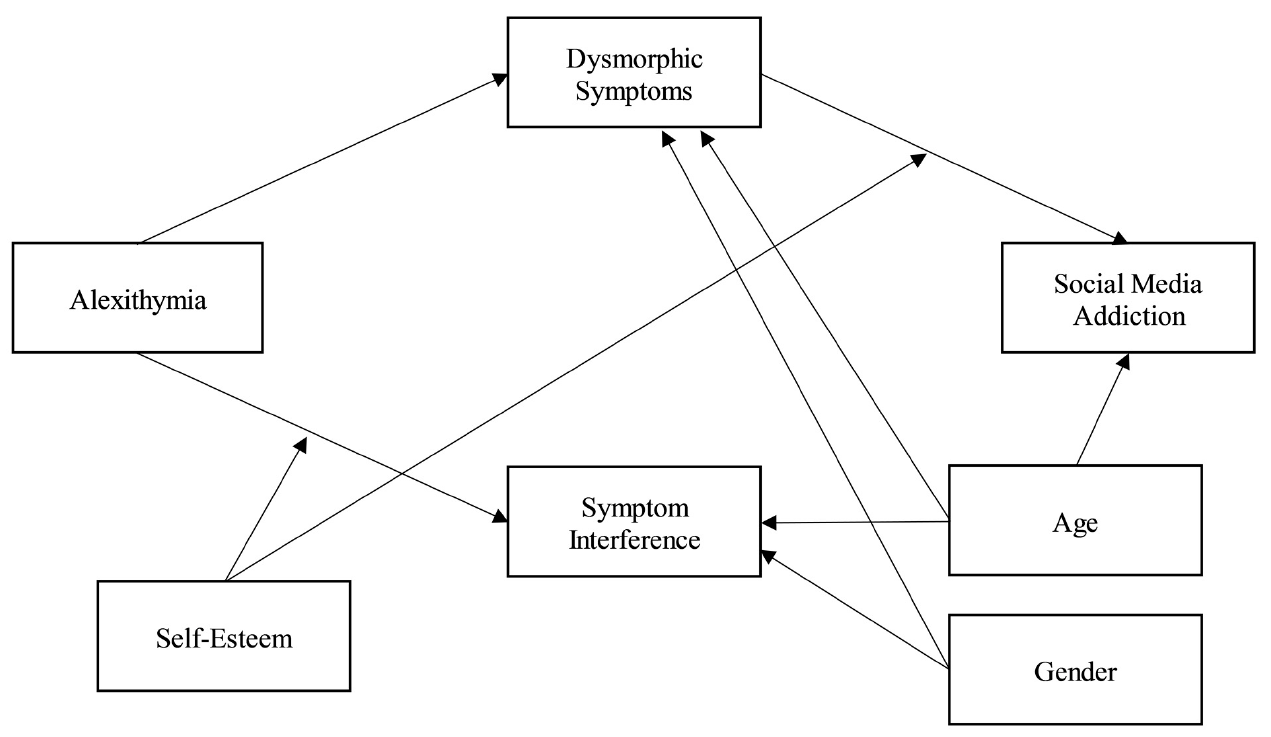
Figure 1. The association between alexithymia and social media addiction, exploring the role of dysmorphic symptoms, symptoms interference, and self-esteem, controlling for age and gender: a moderated mediation model. Note: Only the emerged significant relationships have been graphi- cally represented.